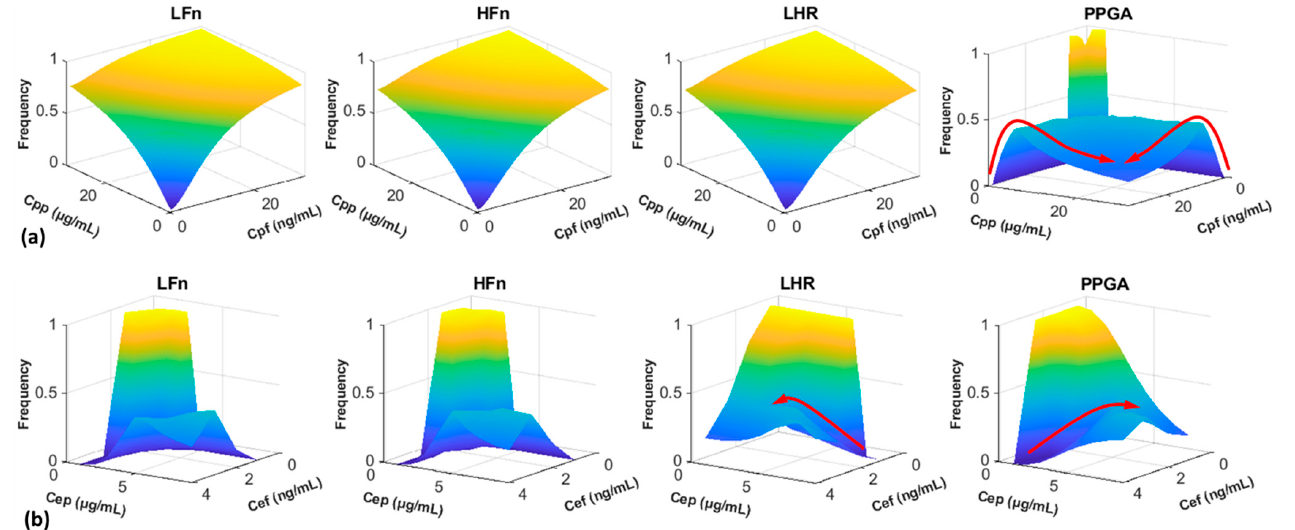
Figure 3. ( a , b ) The global three-dimensional morphologies of activities on the ANS in terms of plasma concentrations (Cp) and effect-site concentrations (Ce), respectively. This figure exhibits only the mixture of Groups 1 and 2. The red arrows represent the changing path of the drug with negative steepness.